Question: Write a single sentence explaining what this figure depicts.
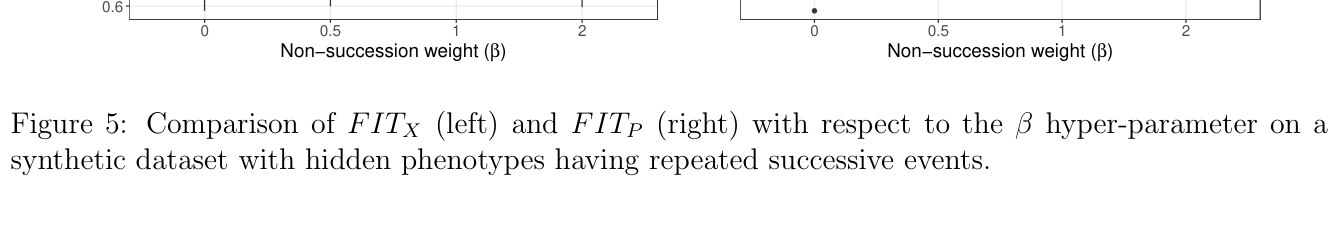
Answer: Comparison of FITX (left) and FITP (right) with respect to the β hyper-parameter on a synthetic dataset with hidden phenotypes having repeated successive events.